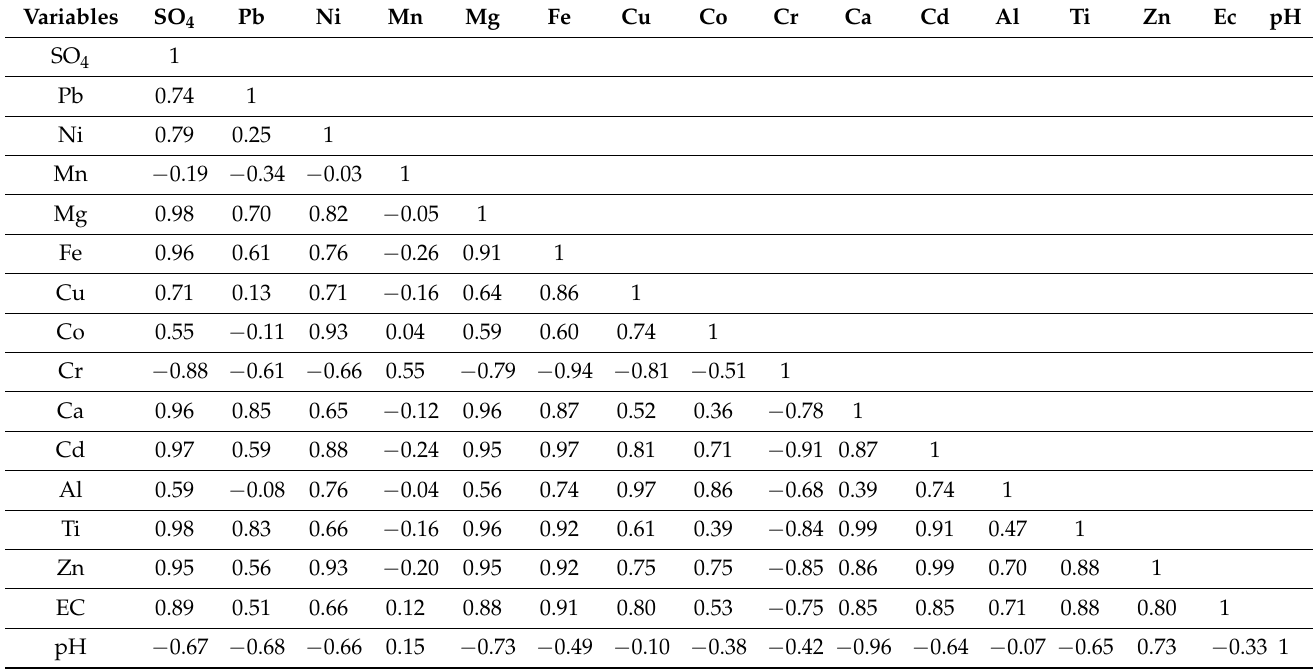
Table 6. Correlation between chemical parameters from observation wells installed on the Aldermac mine site, in 2014 (tenth campaign).